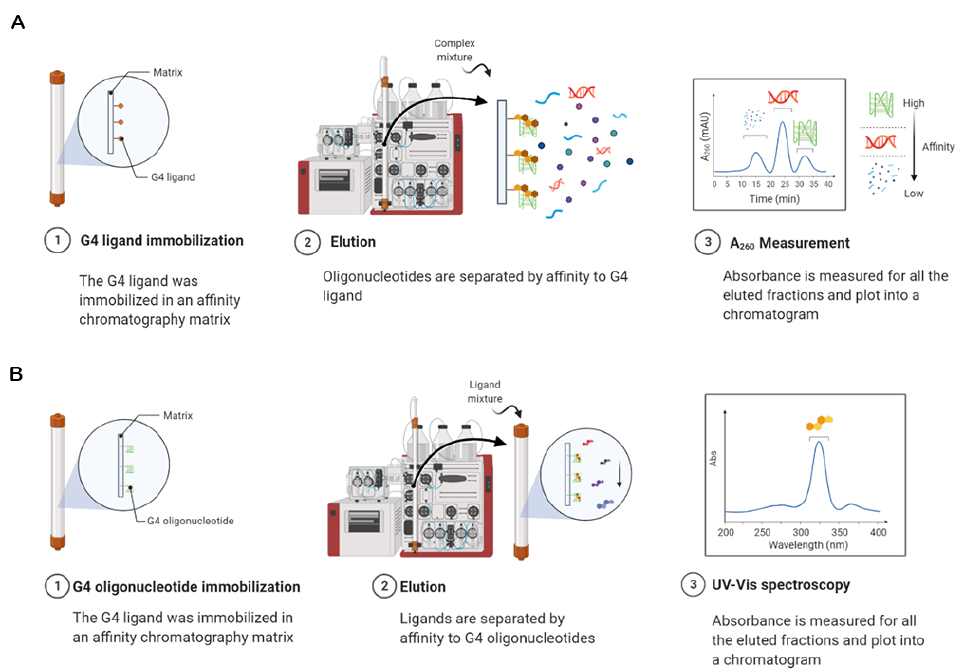
Figure 24. ( A ) Scheme of affinity chromatography strategy to purify G4 sequences based on a ligand affinity chromatography support. ( B ) Scheme of affinity chromatography strategy to purify G4 ligands based on a G4 affinity chromatography support.